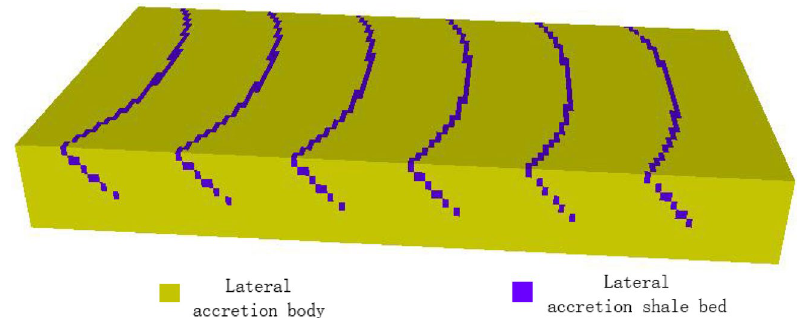
Fig. 4 Conceptual model of point bar